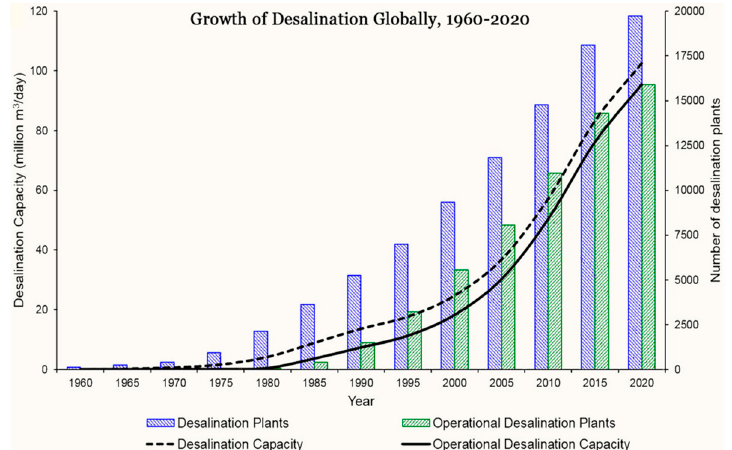
Figure 10. Variations of desalination across the world in the last three decades